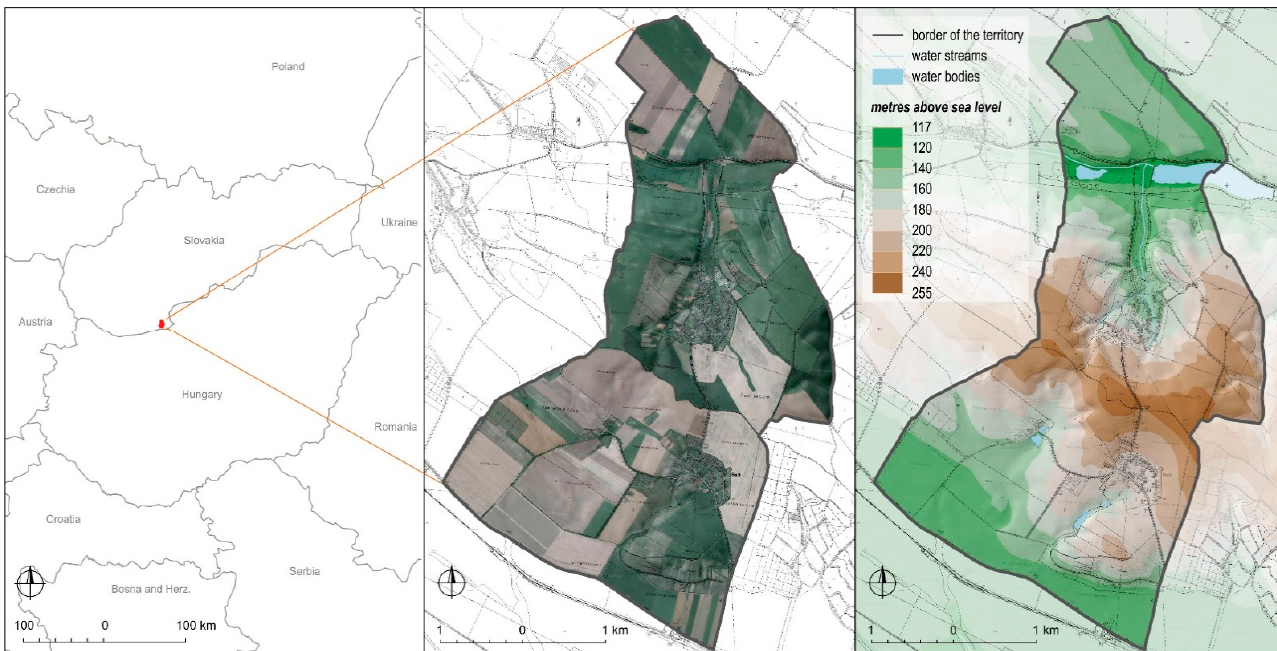
Figure 1. Delimitation of the study area within the Slovak republic, aerial view of the configuration of agricultural land mosaic and division into basic hypsometric degrees (Adapted from [https://zbgis.skgeodesy.sk/mkzbgis/sk/teren, accessed on 18 June 2021], with permission from The Geodesy, Cartography and Cadastre Authority of the Slovak Republic, 2021)).